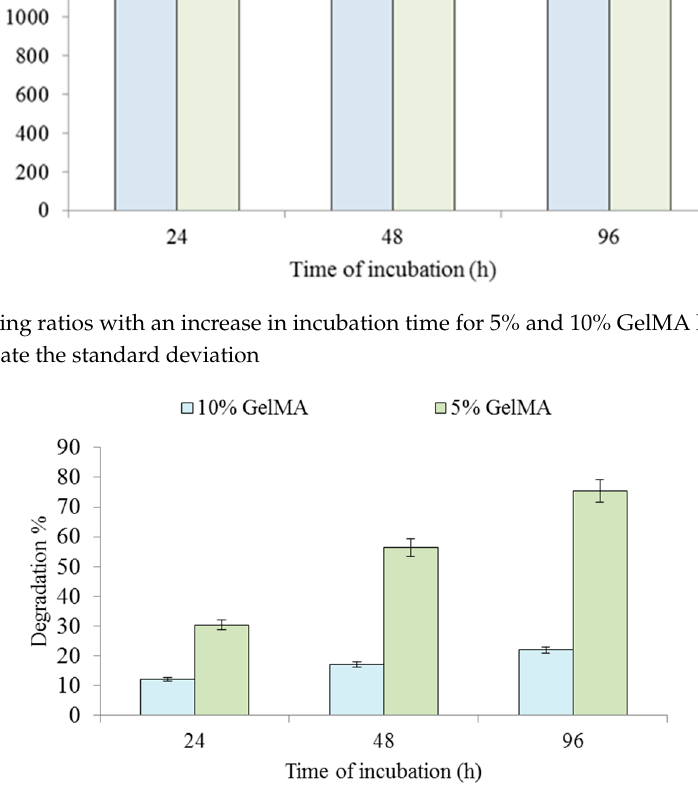
Figure 7. Degradation with an increase in incubation time for the cell-encapsulated GelMA hydrogels. The error bars indicate the standard deviation